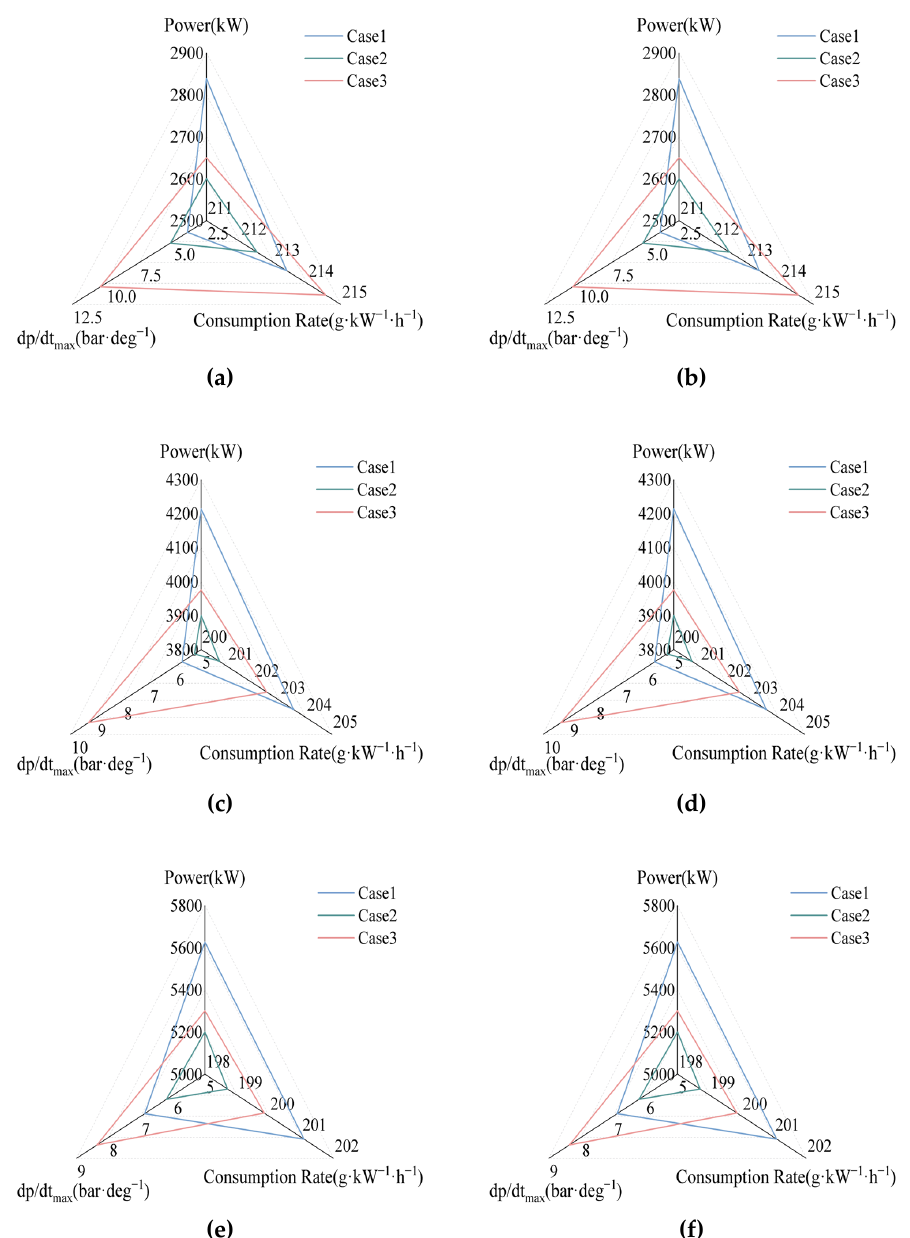
Figure 12. Comprehensive comparison for variable EBP at different loads. ( a ) EBP = 10 kPa, load = 50%; ( b ) EBP = 25 kPa, load = 50%; ( c ) EBP = 10 kPa, load = 75%; ( d ) EBP = 25 kPa, load = 75%; ( e ) EBP = 10 kPa, load = 100%; ( f ) EBP = 25 kPa, load = 100%.